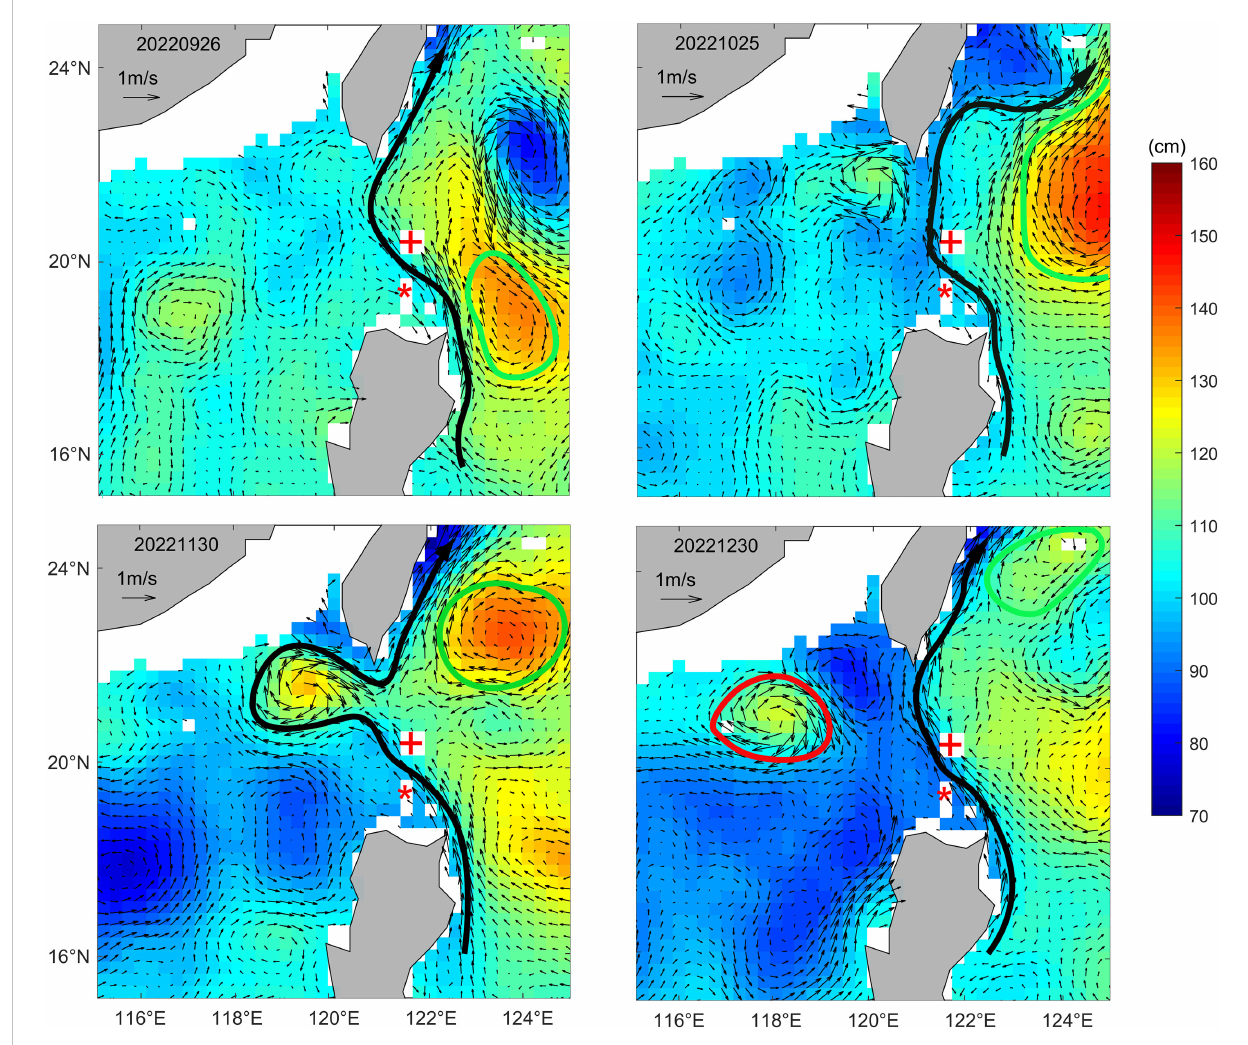
FIGURE 1 Absolute dynamical topography (cm; shading) and geostrophic currents (m/s; vector) in the northeastern SCS showing an anticyclonic eddy shed from the Kuroshio in 2022. A westward-moving anticyclonic eddy from the northwestern Paci fi c interacted with the Kuroshio in the Luzon Strait area inducing the Kuroshio transition. Regions with water shallower than 100 m are in white. The Batanes Island Chain and Babuyan Island Chain are marked by red plus and asterisk, respectively. The black, red, and green bold curves represent the Kuroshio axis, the anticyclonic eddy shed from the Kuroshio, and the westward-moving anticyclonic eddy from the northwestern Paci fi c, respectively. SCS, South China